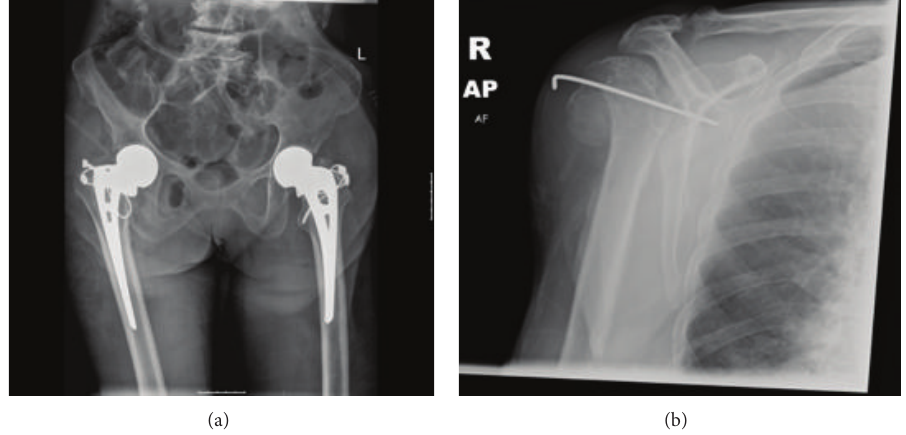
Figure 3: Postoperative radiographs demonstrating (a) bilateral hemiarthoplasties and (b) K-wire stabilisation of the right shoulder.